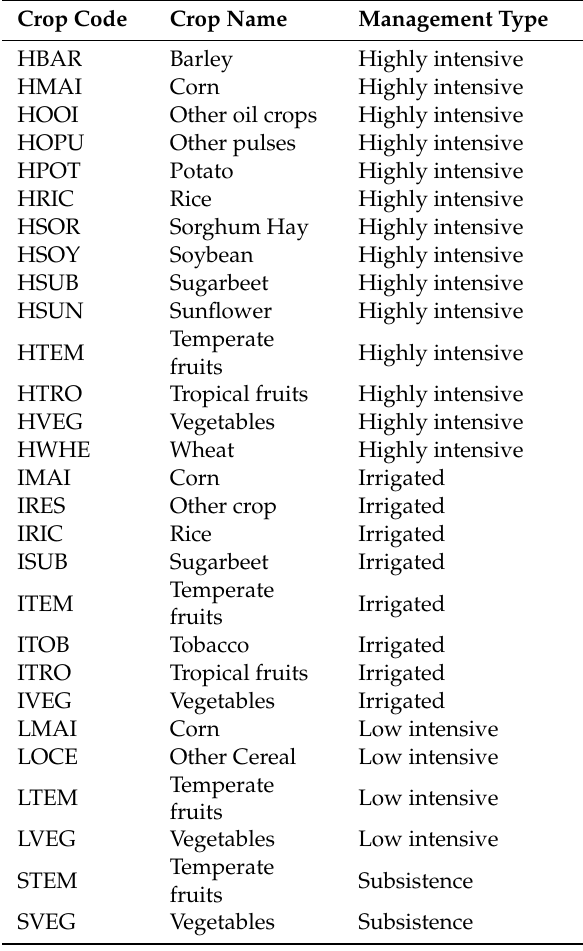
Table A1. SWAT crop code and